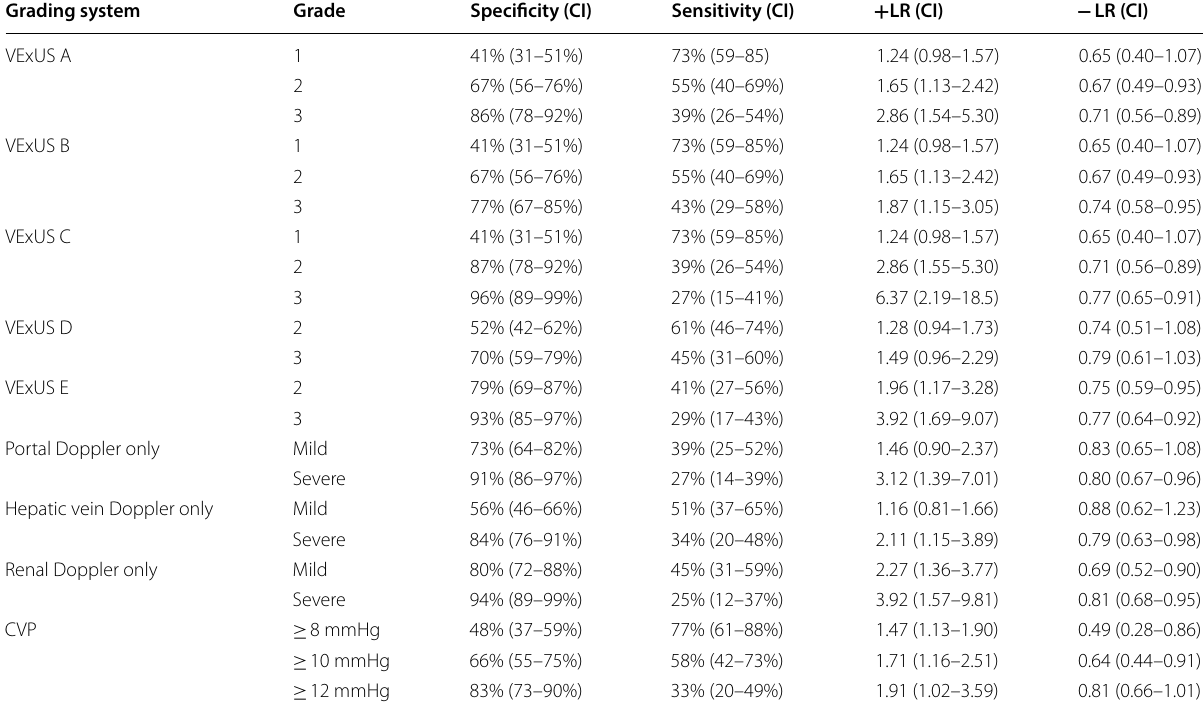
Table 3 Performance parameters of the different VExUS grading systems assessed at ICU admission to predict acute kidney injury in 145 patients after cardiac surgery